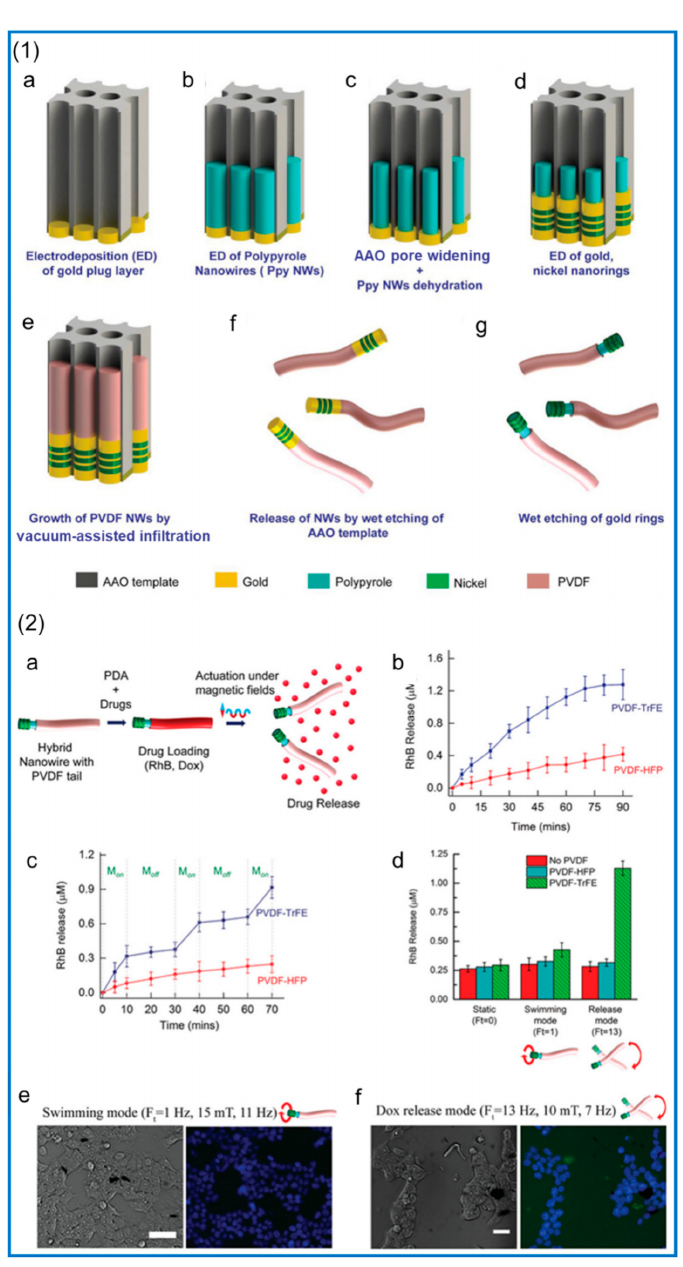
Figure 13. ( 1 ) Fabrication process of nano-electric eel, ( a ) Au sputtering and electrodeposition of Au plug layer in an AAO membrane, ( b ) electrodeposition of Ppy NWs, followed by ( c ) their dehydration and the pore widening of AAO template to allow for ( d ) sequential electrodeposition of Ni and Au nanoring segments. ( e ) Vacuum infiltration to form PVDF NWs, and RIE etching. Wet etching of ( f ) AAO template and ( g ) etching of gold nanoring segments to obtain released hybrid nano-electric eel. Reprinted with permission from Ref. [190], copyright 2019, John Wiley & Sons, Ltd. ( 2 ) Controlled drug release of mixed nano-electric eel. ( a ) Schematic representation of the magnetic drug release from mixed nano-electric eel. ( b ) Continuous release of RhB at 10 mT and 7 Hz. ( c ) The amount of RhB released with and without magnetic field. ( d ) Release plots of RhB in NWs without PVDF, with PVDF–HFP, and with PVDF–TRFE, bright-field and fluorescence images of cancer cells cultured with Adriamycin-coated PVDF–TRFE NWs in ( e ) swimming mode and ( f ) drug release mode. Reprinted with permission from Ref. [190], copyright 2019, John Wiley & Sons,